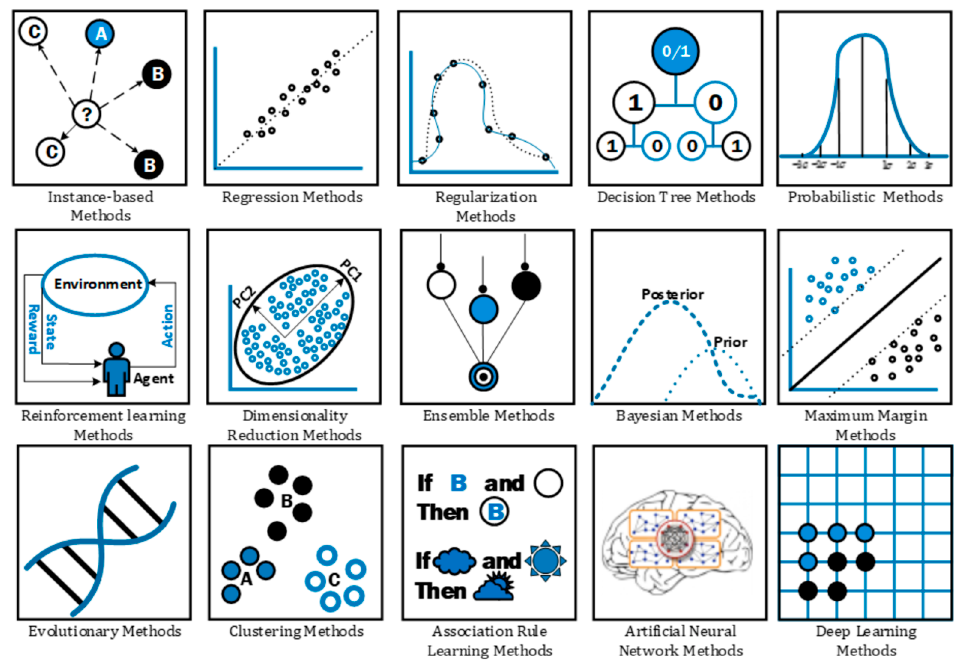
Figure 1. A visual illustration of different categories of machine learning methods used for image classification.